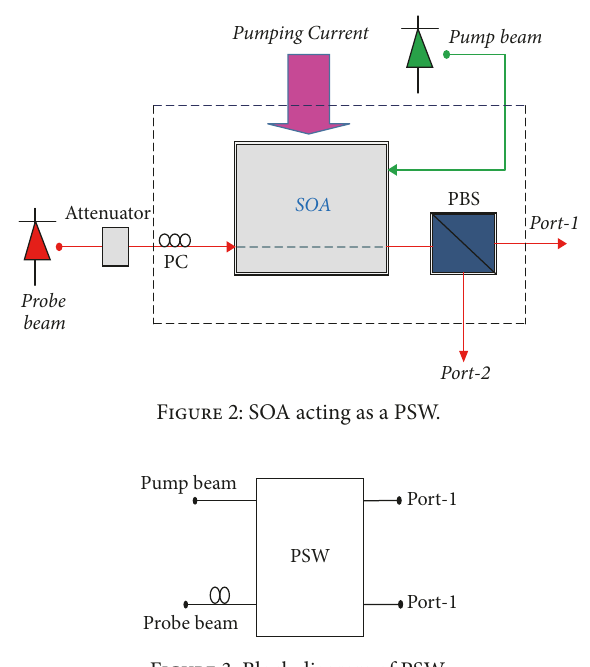
Figure 3: Block diagram of